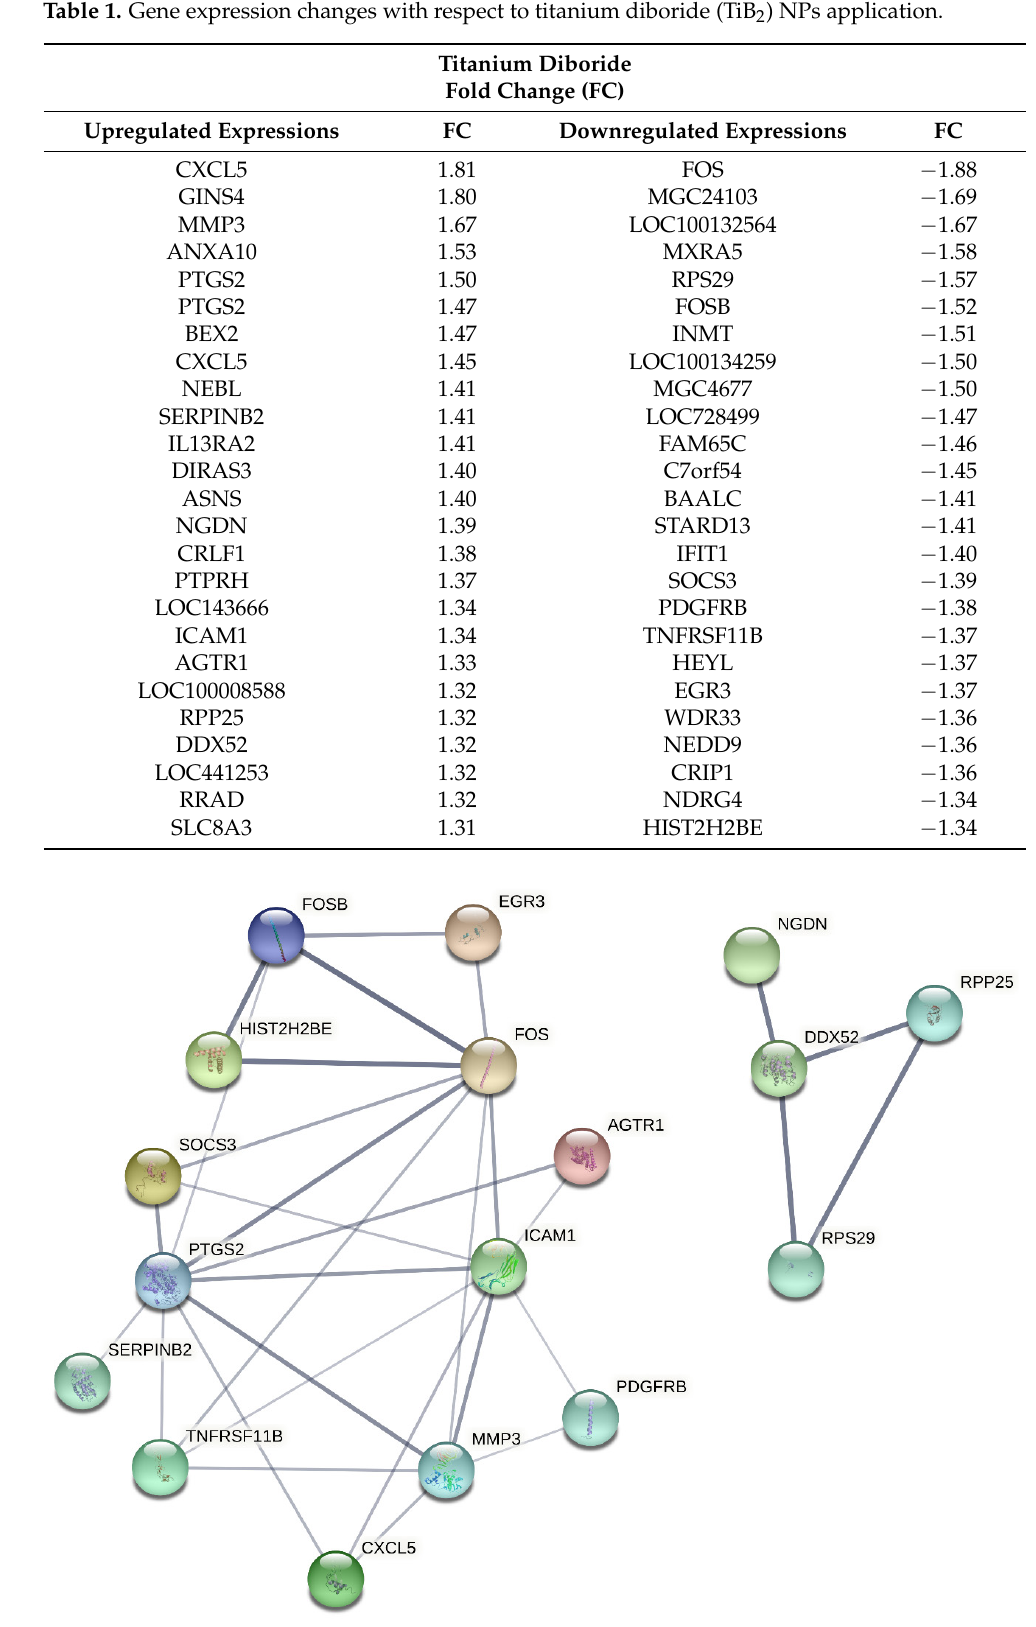
Figure 5. String analysis of titanium diboride (TiB 2 ) NPs.